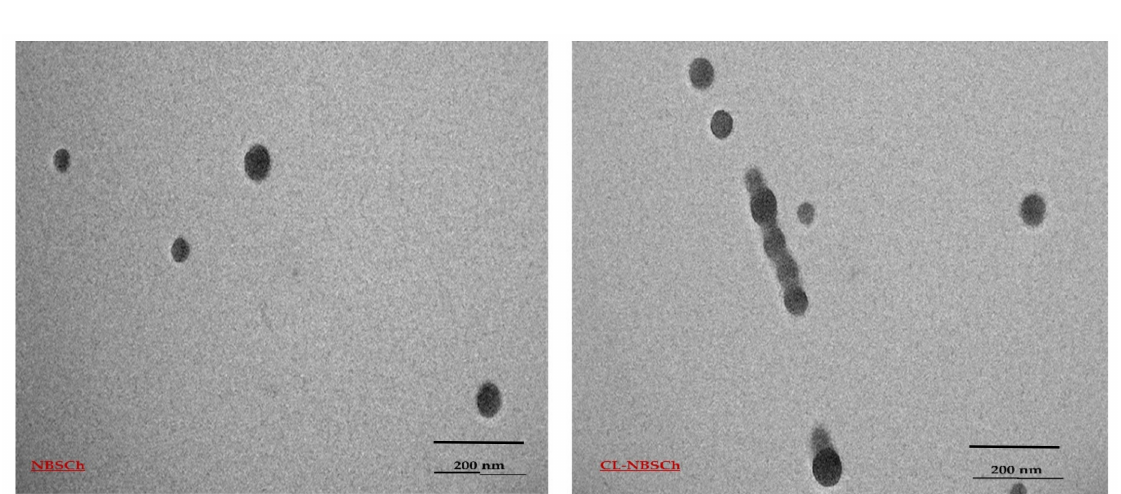
Figure 3. TEM micrographs of blank NBSCh and CL-loaded-NBSCh